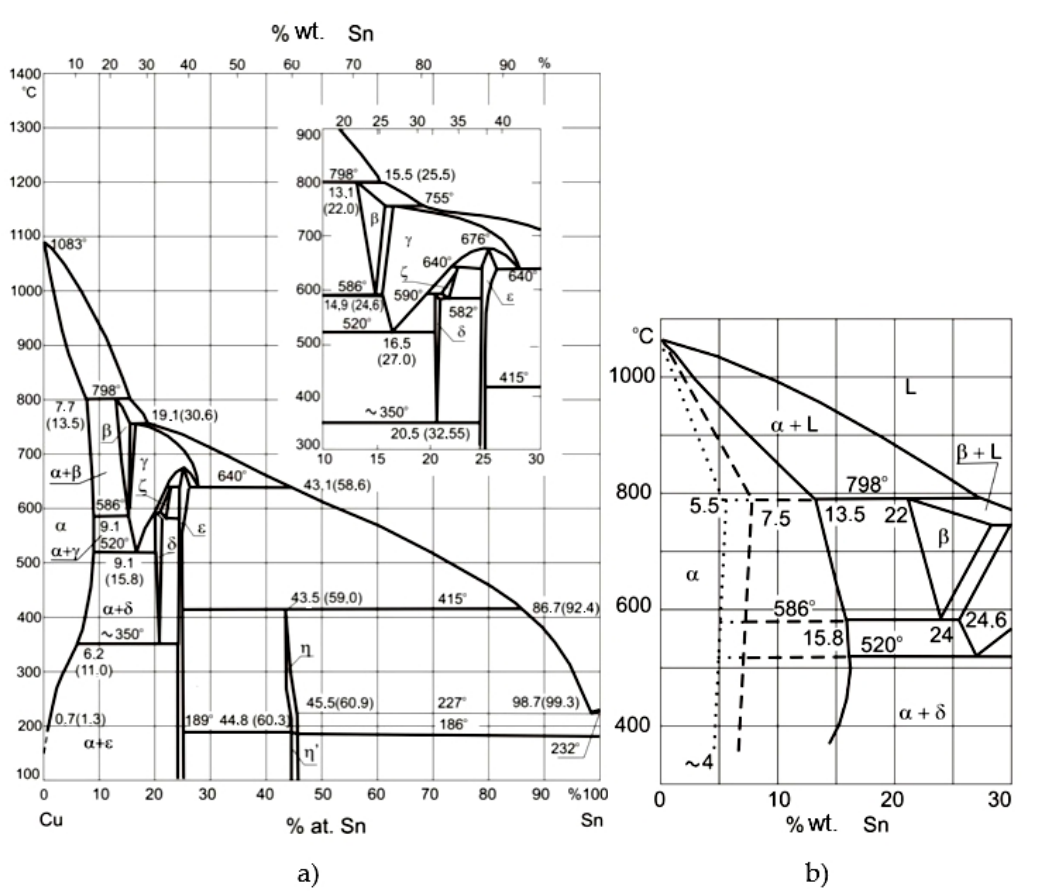
Figure 2. ( a ) Phase diagram Cu-Sn, ( b ) Metastable phases Cu-Sn; dashed line—casting solidified in sandy mold, dotted line—casting solidified in a metal mold [8,9].